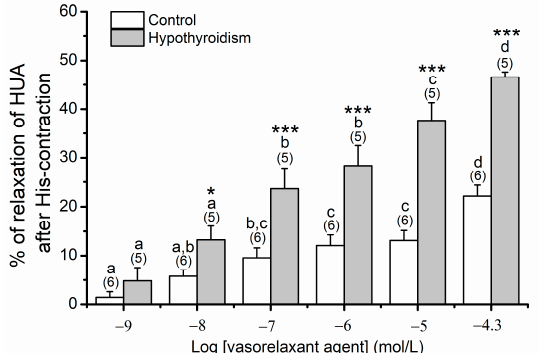
Figure 4. Percentage of relaxation of human umbilical artery (HUA) rings without (control) and with hypothyroidism non-incubated with octylmethoxycinnamate (OMC, 0 µmol/L) and contracted by histamine (His; 10 µmol/L). Each bar represents the mean, vertical lines the S.E.M. and the number within brackets the n . Asterisk * represents a significant difference versus hypothyroidism: * p < 0.05 and *** p < 0.001, and the different letters represents significant differences between OMC concentrations ( p < 0.05); two-way ANOVA method followed by Holm–Sidak post-hoc tests.